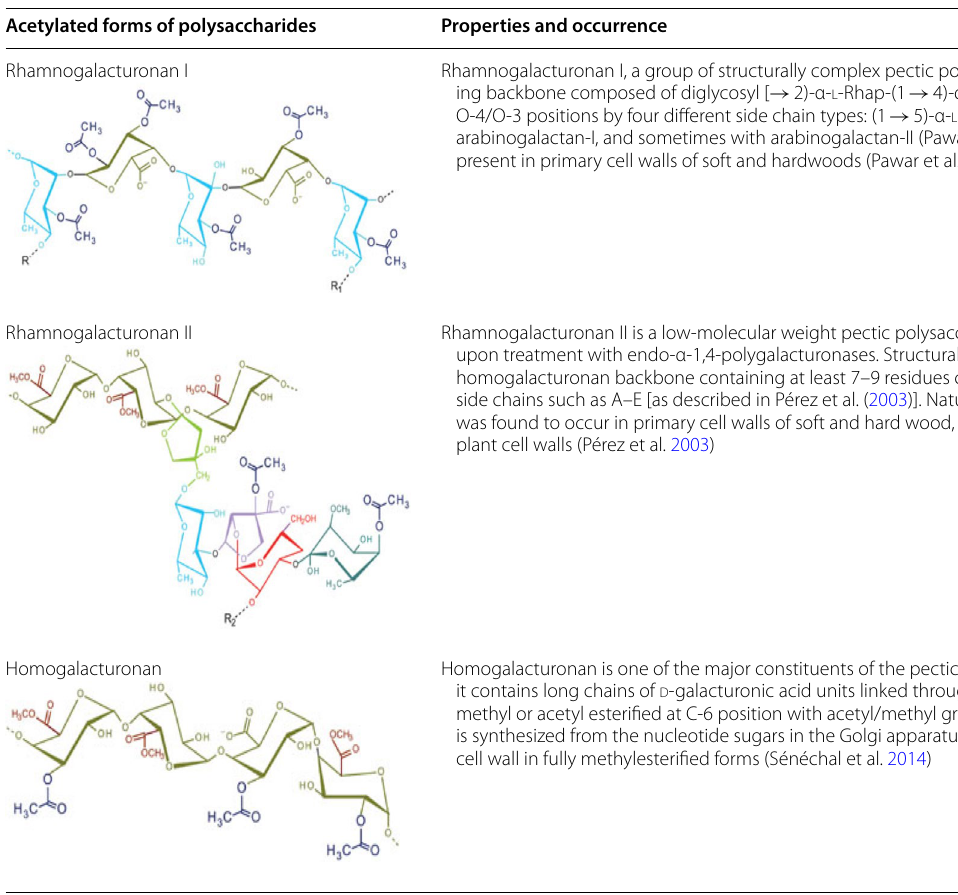
Table 1 Structural properties and occurrence of different O -acetylated pectin structures reported below were retrieved from (Pawar et al.